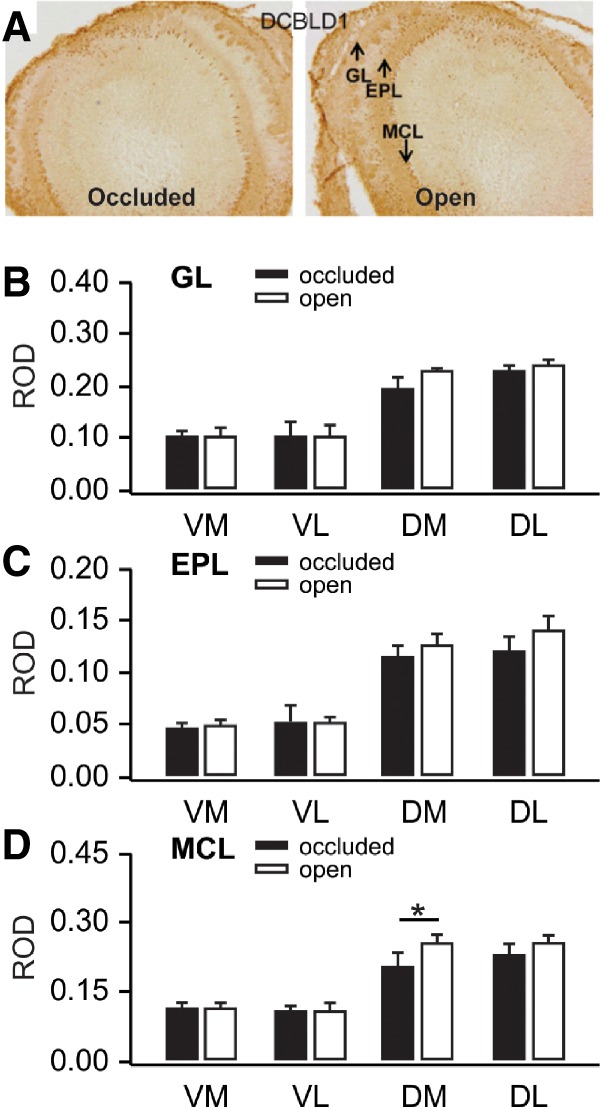
(A) Dcbld1 immunohistochemical staining in olfactory bulbs ipsilateral to open and closed nares 50 min following odor stroking training. (B) Glomerular layer ROD values for olfactory bulb quadrants receiving input from open and closed nares. (C) External plexiform ROD values for olfactory bulb quadrants receiving input from open and closed nares. (D) Mitral cell layer ROD values for olfactory bulb quadrants receiving input from open and closed nares. Error bars represent SEMs. * P < 0.05, see results for exact values.